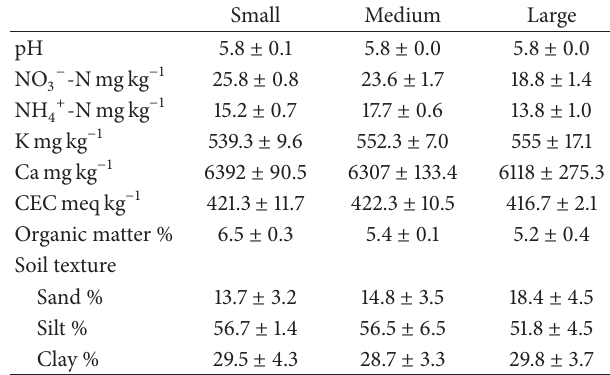
Table 1: Soil pH and nutrients (NO 3− -N, NH 4+ -N, exchangeable- K + , and exchangeable-Ca 2+ ) in soil (mgkg −1 soil) measured for each aggregate size. The soil: water ratio for the soil pH measurement was 2 :5. The inorganic-N was measured using a colorimetric method. Exchangeable-K + and -Ca 2+ were measured using an atomic absorption method after the extraction with a NH 4 COOH